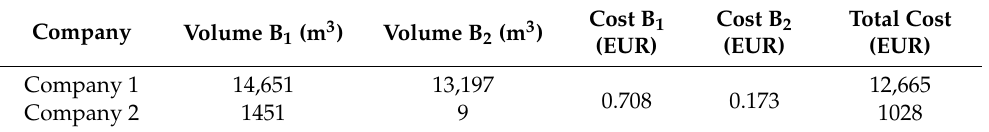
Table 9. Sector 1: quality production costs B 1 and B 2 .